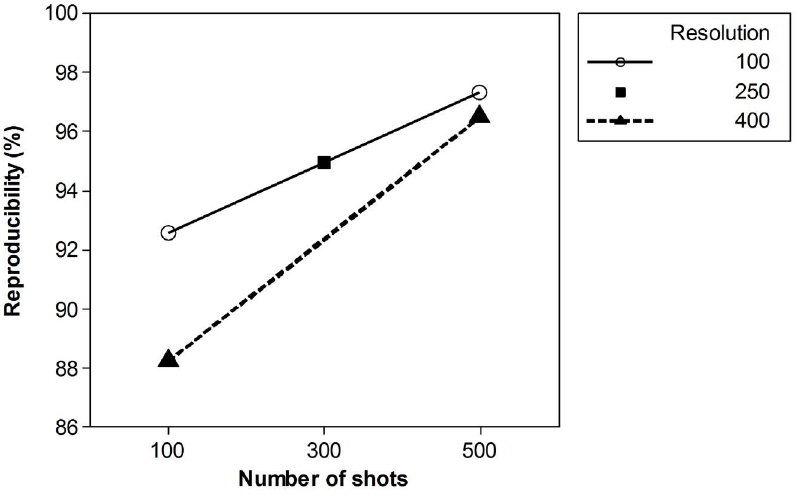
Figure 3. Interaction of threshold minimum resolution and number of shots summed. Effects on spectrum reproducibility during characterization of P. aeruginosa using automated data acquisition with MALDI-TOF MS.